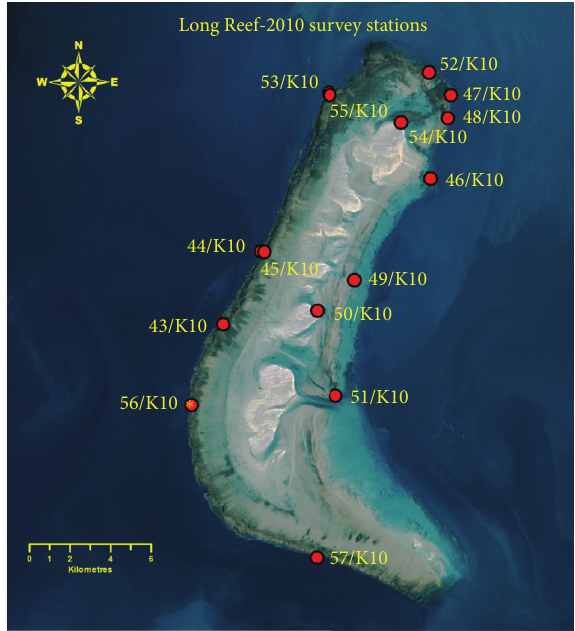
Figure 3: Satellite image of Long Reef with survey stations high- lighted, the Tubipora habitat denoted by a